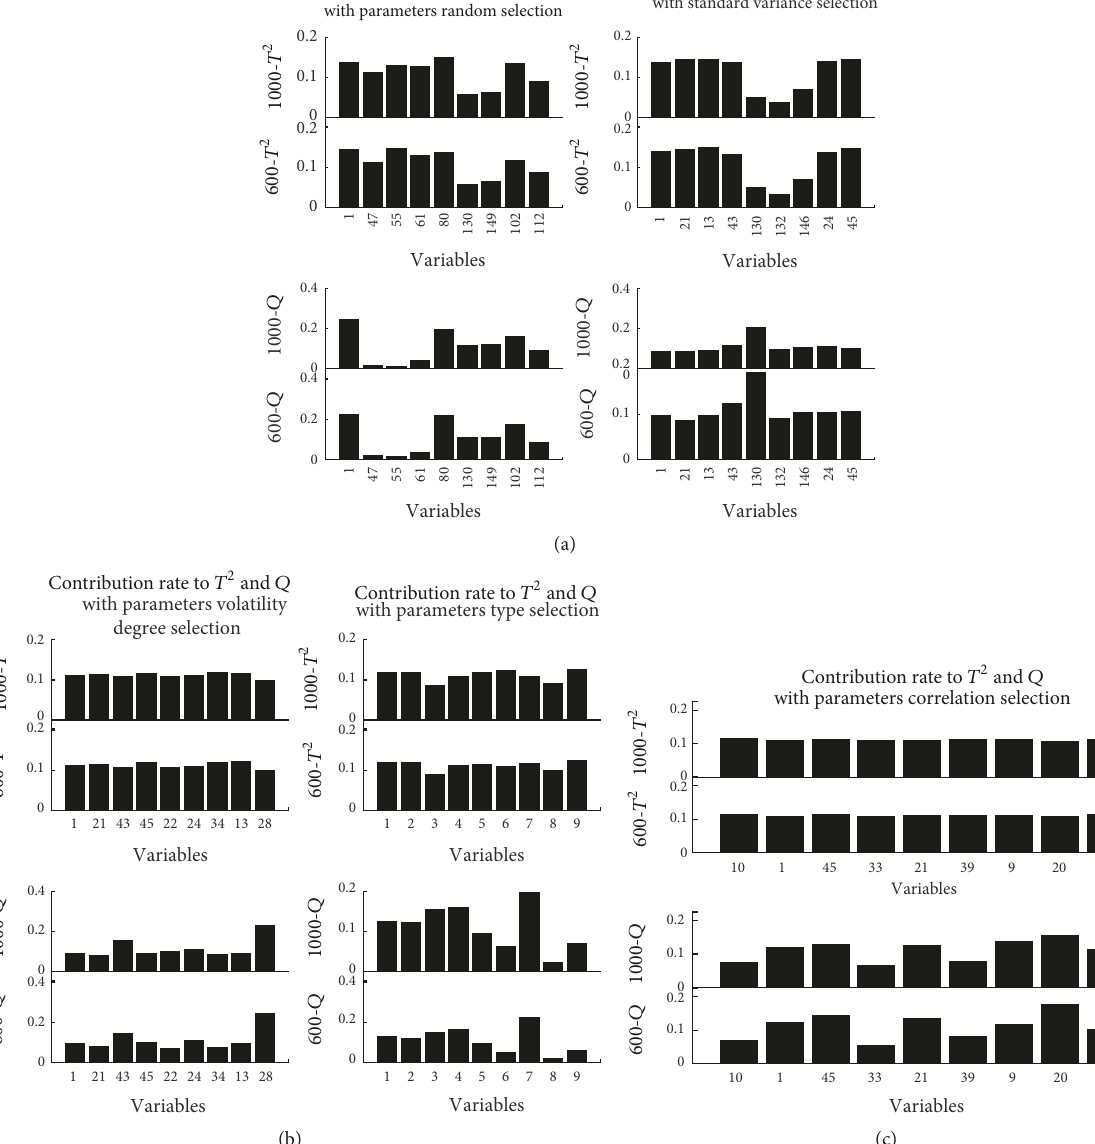
Figure 9: Contributions of sensors to 𝑄 and 𝑇 2 statistics in 5 PCA models under normal